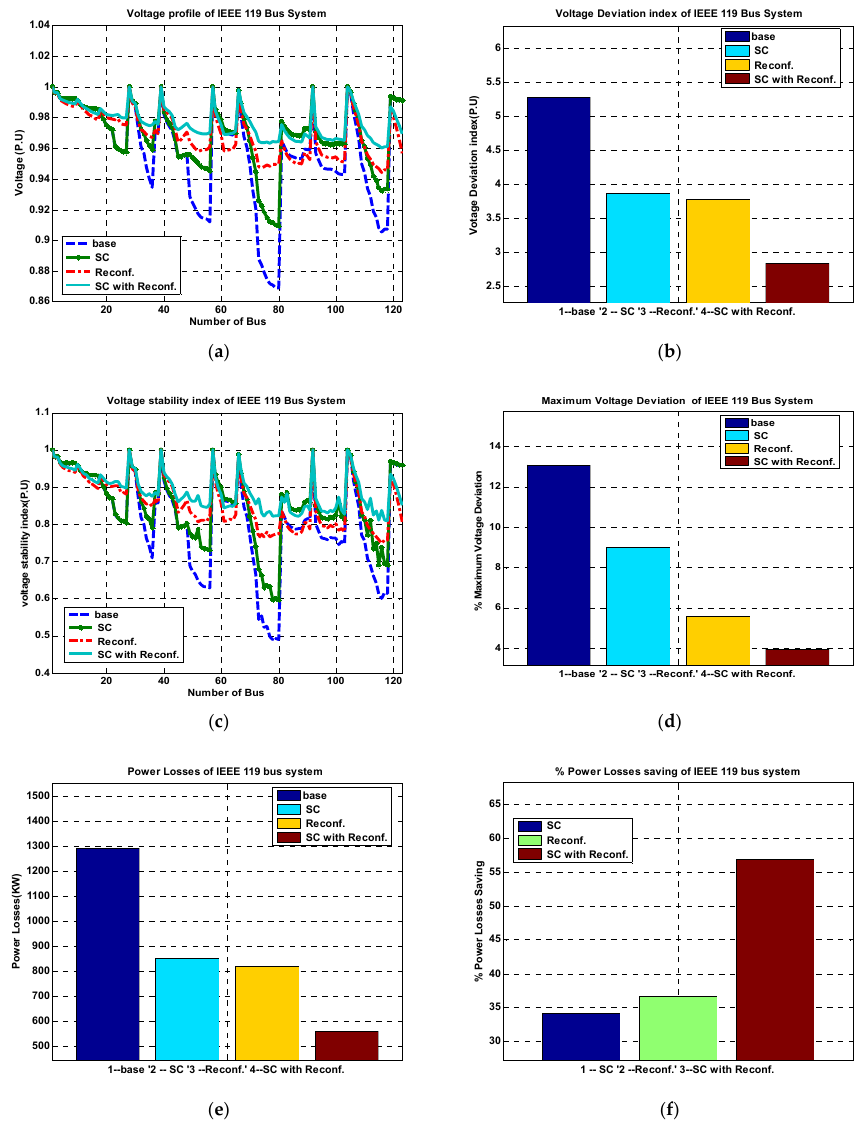
Figure 4. Performance of the 119-node test system with capacitor allocation only, the reconfiguration of the network only, and two approaches via the proposed algorithm: ( a ) Values of voltages at all buses; ( b ) values at different cases of the voltage deviation index; ( c ) values of voltage stability; ( d ) percentage of maximum voltage deviation; ( e ) power losses; ( f ) percentage power losses saving; ( g ) energy cost; ( h ) percentage of energy cost ‐ saving.